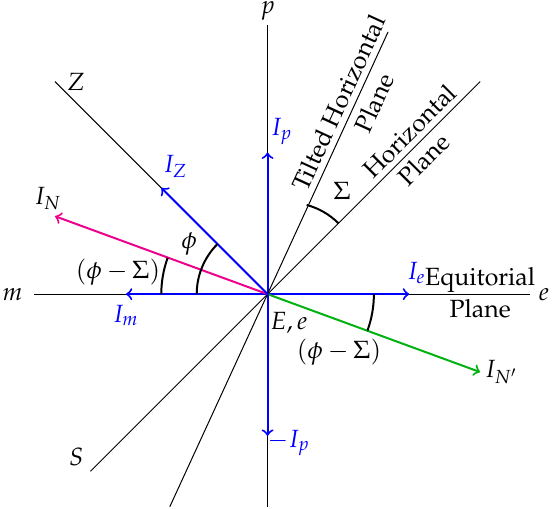
Figure 7. Vector diagram ( 2 D ) of the tilted surface showing vectors I N and I N (cid:48)